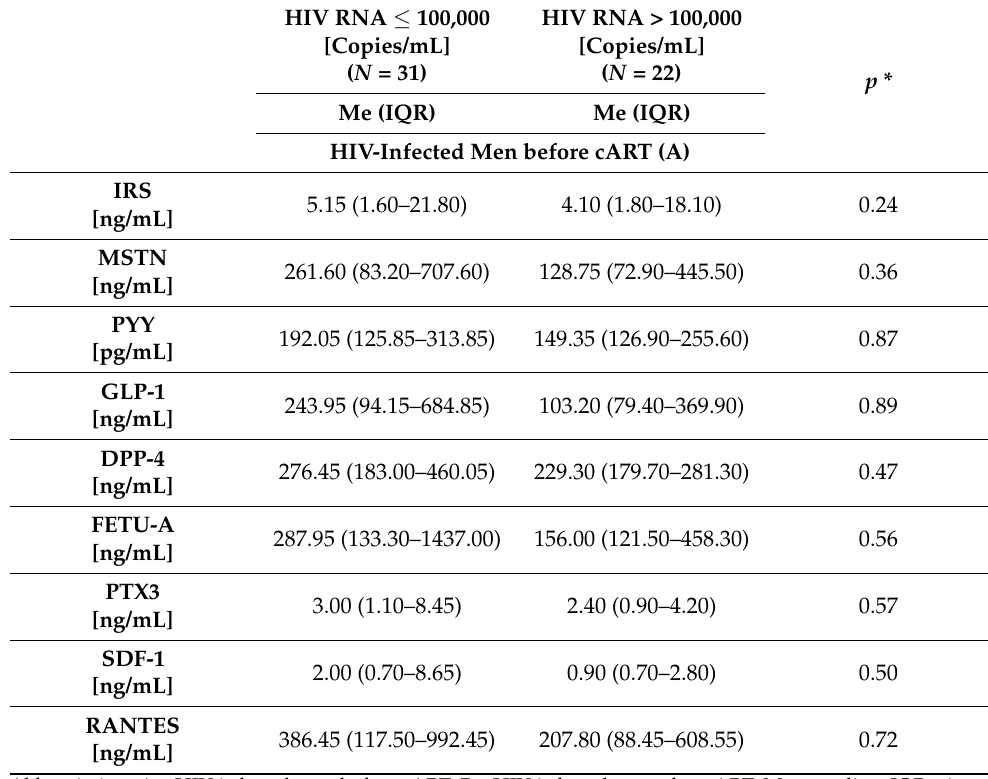
Table 5. Results of selected parameters before and after cART in HIV-infected men by HIV RNA viral load (below and above 100,000 copies/mL) with statistical